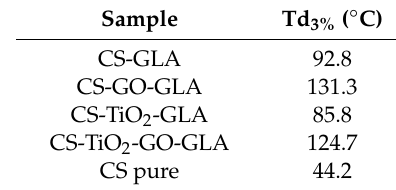
Table 2. Td 3% of the nanocomposite beads (CS-GLA, CS-GO-GLA, CS-TiO 2 -GLA, and CS-TiO 2 -GO- GLA).